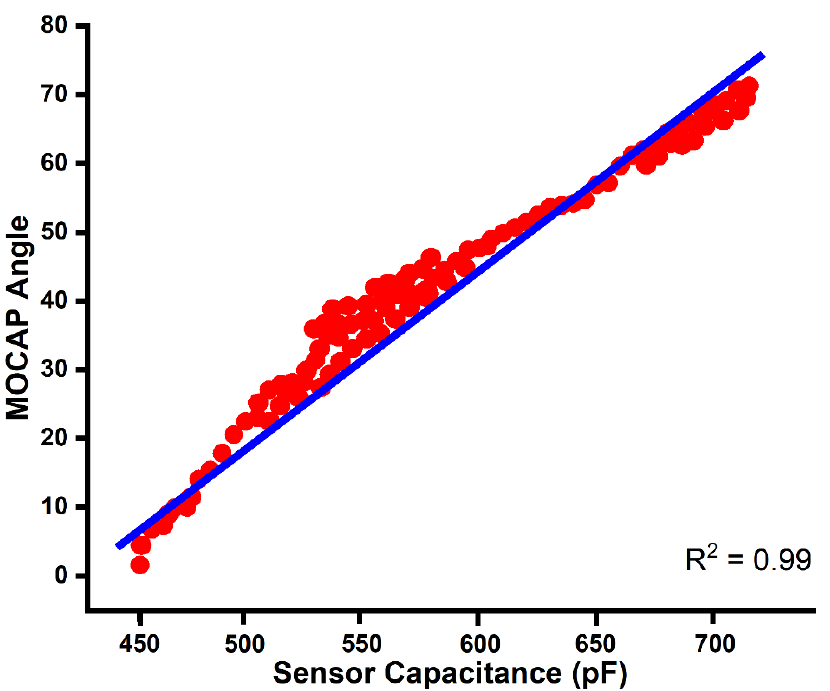
Figure 4. Comparison of joint angle to capacitance during plantarflexion of the foot-ankle complex. Motion capture (MOCAP) was used to determine the joint angle, while the capacitance data were collected using StretchSense™ StretchFABRIC sensors to produce this linear model correlating the two datasets. Adapted with permission of Saucier et al. [8] , 2019, David Saucier.